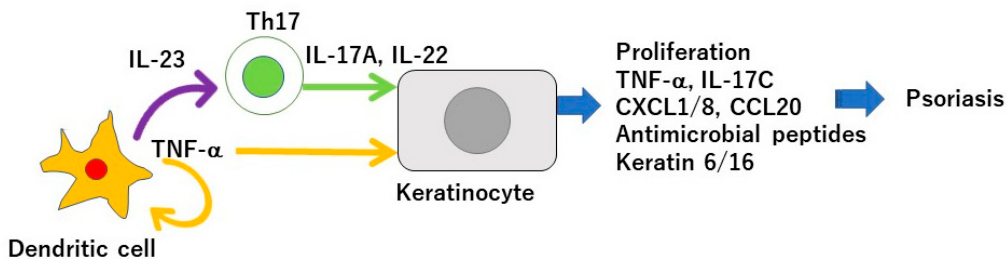
Figure 1. Tumor necrosis factor(TNF- α ) / interleukin-23 (IL-23) / IL-17 axis in the pathogenesis of